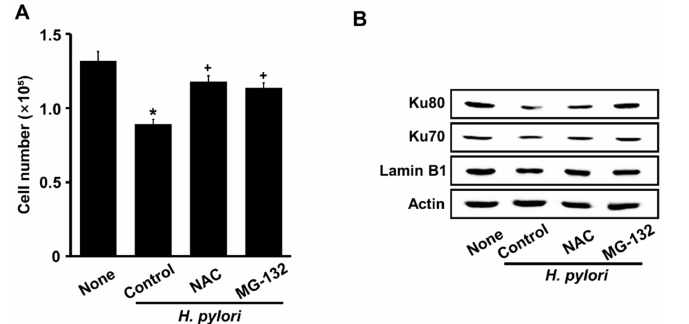
Figure 5. Both NAC and MG-132 suppress H. pylori -induced cell death and loss of nuclear Ku70/80 in AGS cells. Cells were incubated with 1 mM NAC or 0.5 µ M MG-132 for 1 h, then stimulated with an H. pylori to AGS cells ratio of 100:1 for 24 h. ( A ) Viable cells were evaluated by trypan blue exclusion. All data are shown as means ± S.E. of three independent experiments. * p < 0.05 vs. None (unstimulated cells without NAC or MG-132). + p < 0.05 vs. Control ( H. pylori -stimulated cells without NAC or MG-132). ( B ) Western blots of Ku70/80 in nuclear extracts with actin and lamin B1 as loading control and nuclear marker,